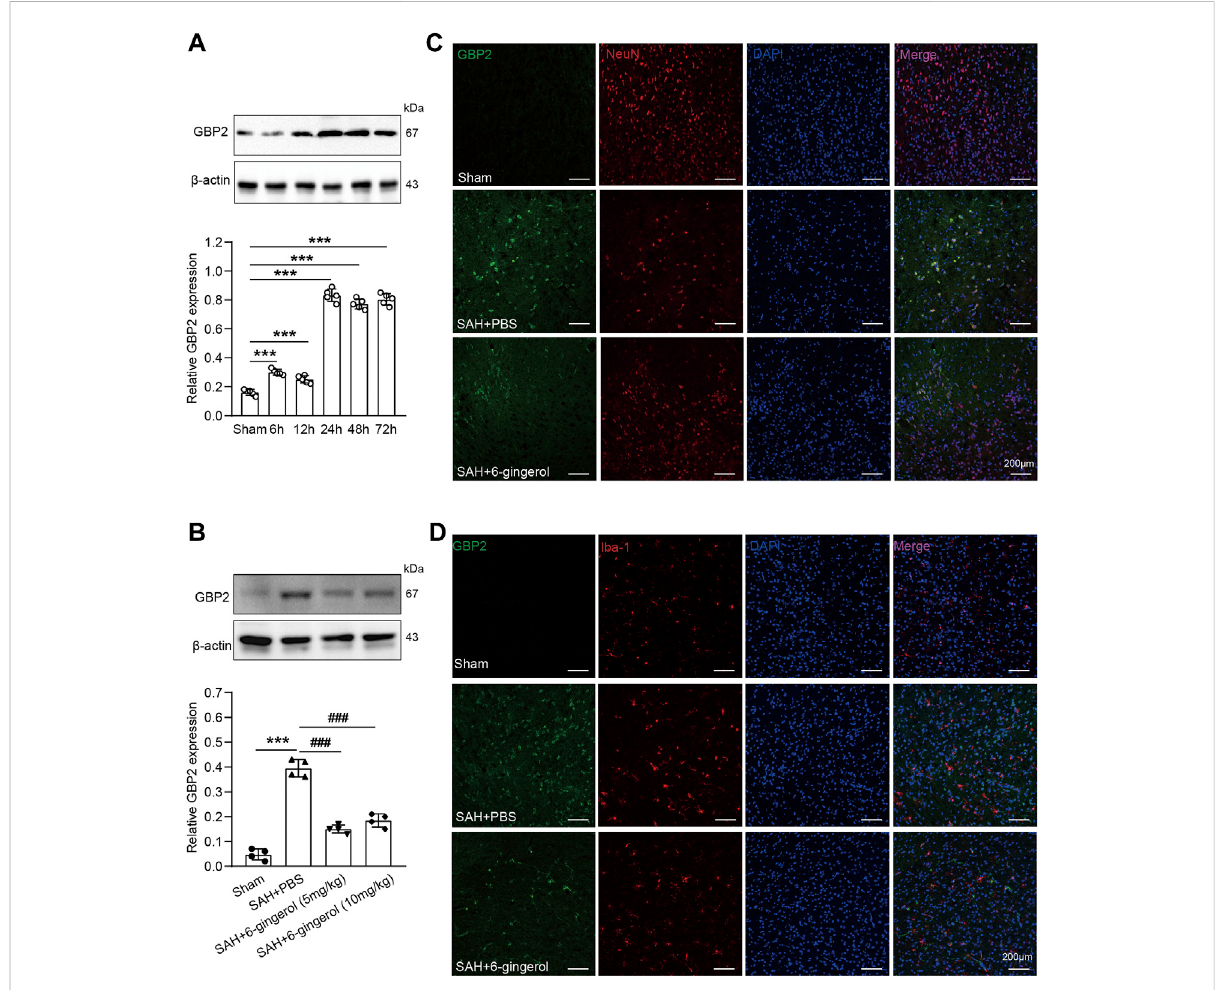
FIGURE 4 6-gingerol inhibits GBP2 expression in SAH rats. (A) GBP2 protein expression was determined by immunoblot at preset times post-SAH and quantitativewesternblot,n=5.One-wayANOVAwasusedfollowedbyTukey ’ sposthoctest. (B) GBP2proteinexpressionwasevaluatedbywestern blotting in sham, SAH + PBS, SAH + 6-gingerol (5 mg/kg) and SAH + 6-gingerol (10 mg/kg) rats, and quantitative western blot, n = 4. One-way ANOVA was used followed by Tukey ’ s post hoc test. (C) Representative images of GBP2/NeuN immuno fl uorescence staining of brain sections fromratsinthesham,SAH+ PBSandSAH+6-gingerol groups.Scalebar =200 μ m. (D) Representative images ofGBP2/Iba-1immuno fl uorescence staining of brain sections from rats in the sham, SAH + PBS and SAH + 6-gingerol groups. Scale bar = 200 μ m *** p < 0.001 vs sham group; ### p < 0.001 vs SAH + PBS